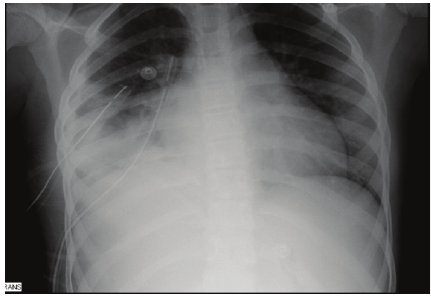
Figure 1: Bilateral pneumonia with effusion.